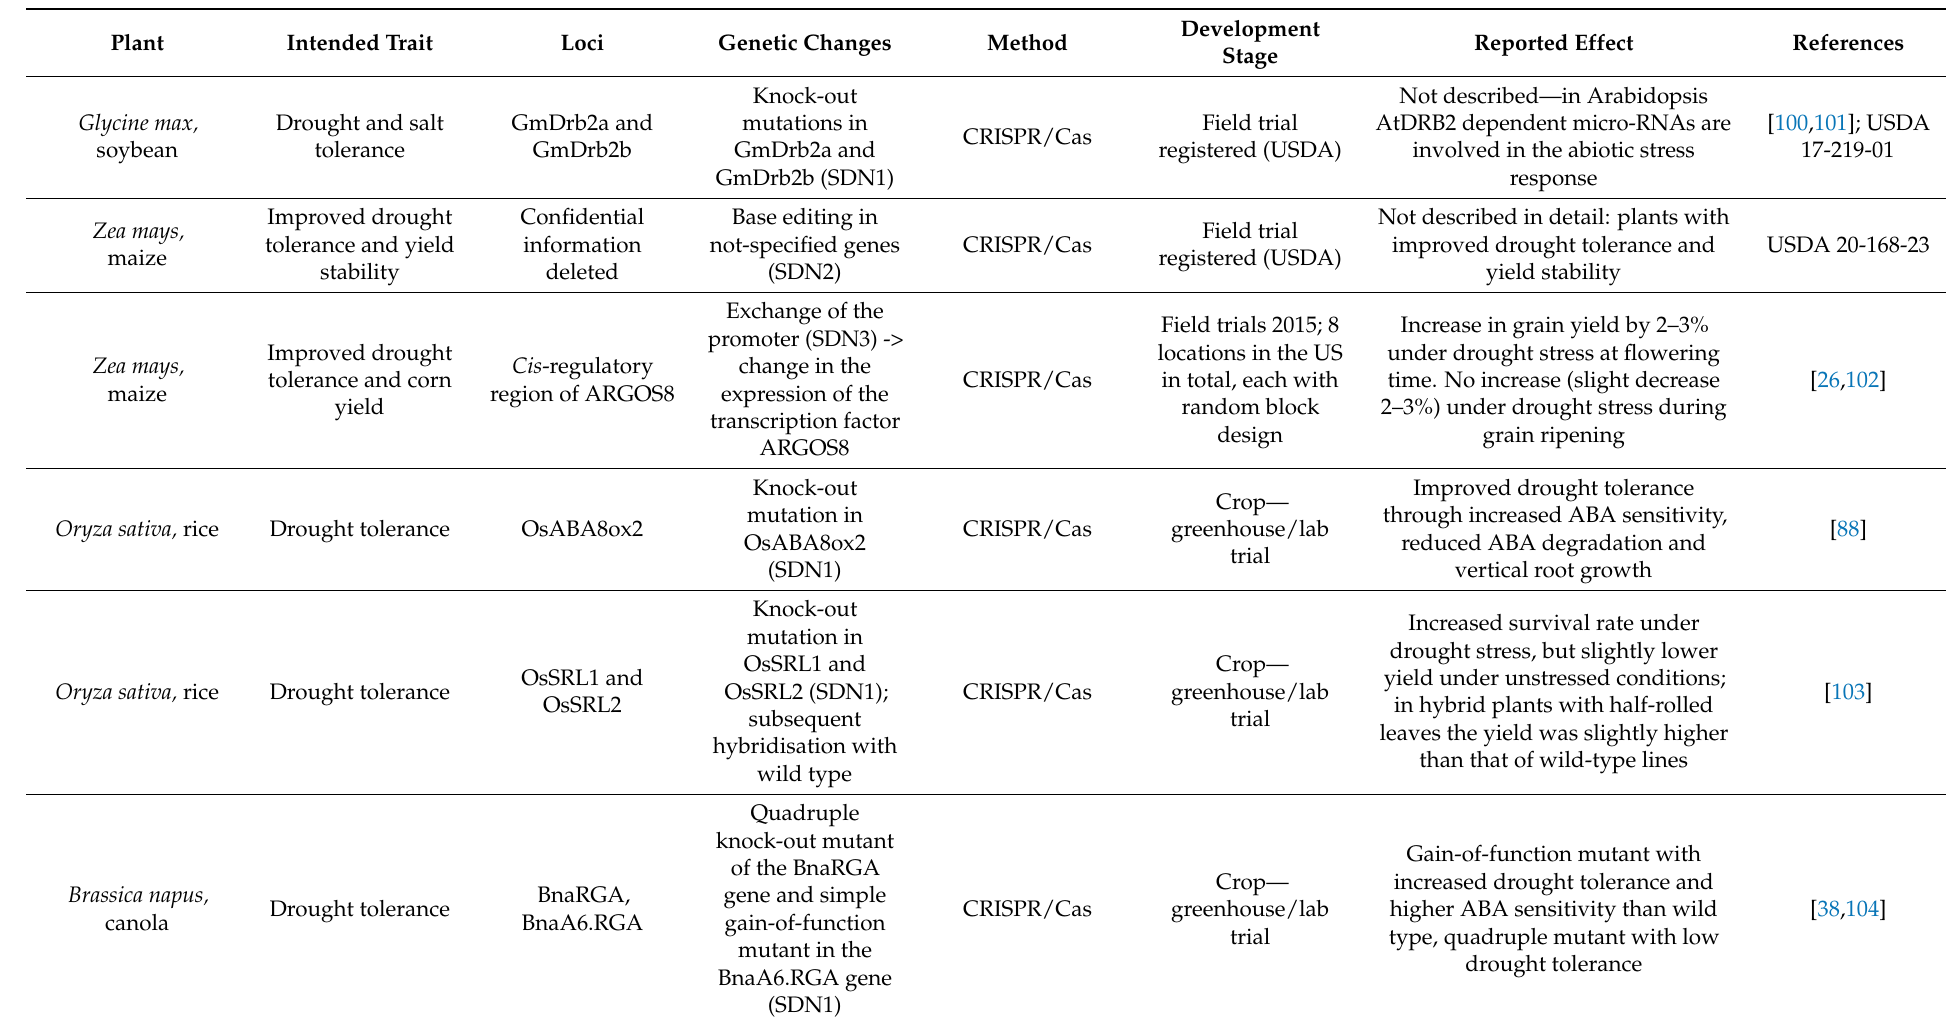
Table 2. Overview of the plants under development with NGT, aiming at characteristics of increased drought